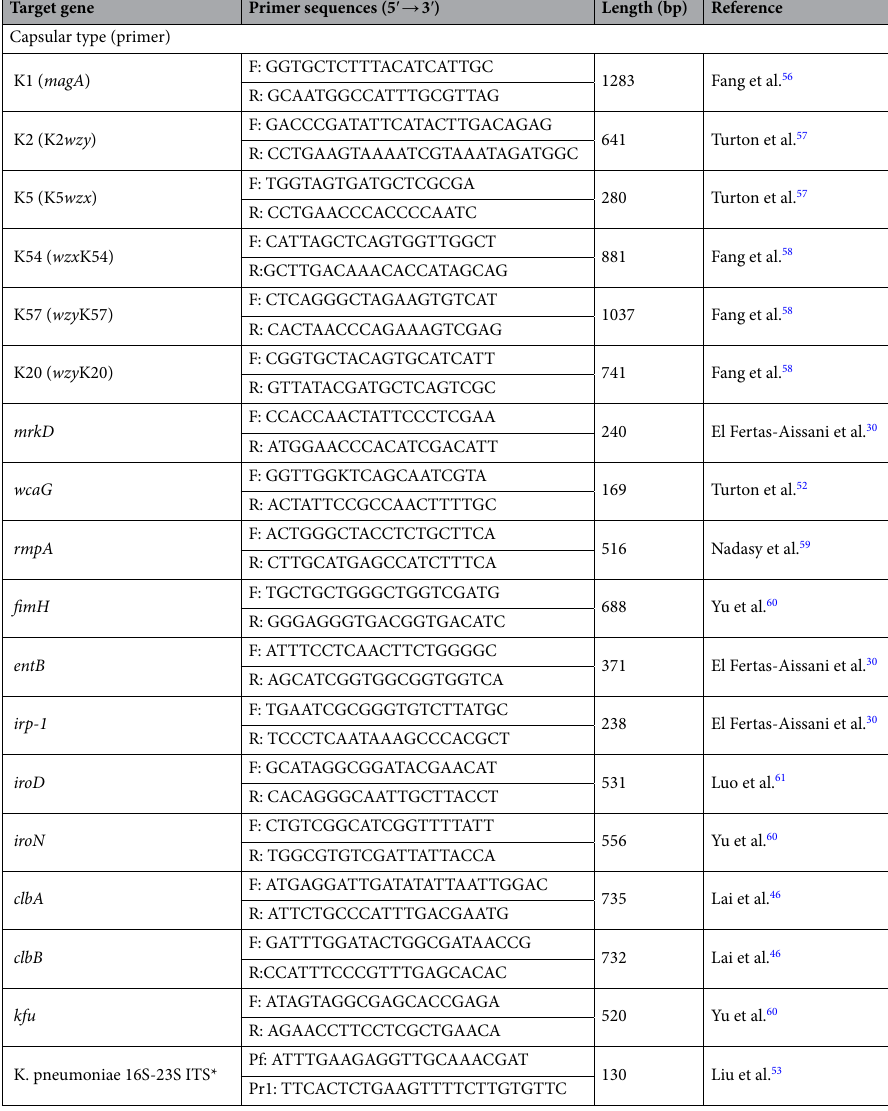
Table 8. Primers used for PCR. *Internal transcribed